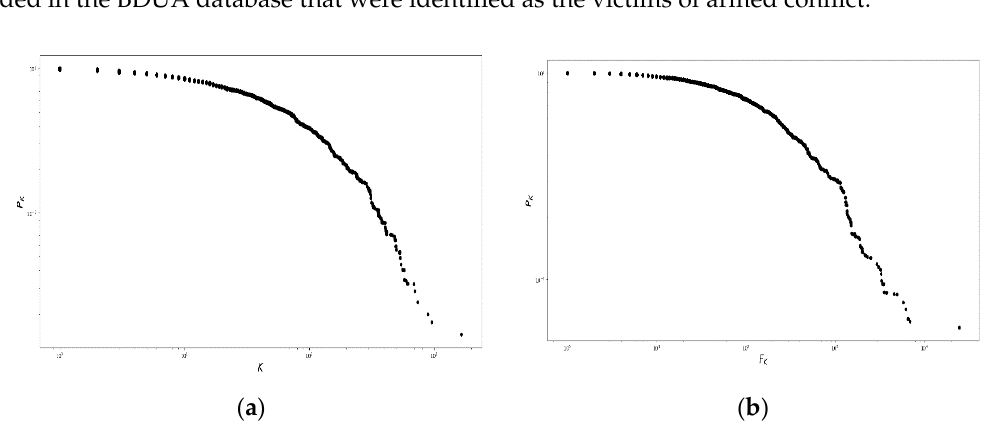
Figure 6. Nodal degree and nodal strength for the victims of the armed conflict in Colombia, resident in the Risaralda province. Complementary cumulative distribution functions of ( a ) the nodal degree K , and ( b ) the nodal strength 𝐹 𝐾 for the Morbidity Network of Diagnoses for the victims of the armed conflict in Colombia, residing in the Risaralda province , from 2011 to 2016. Source: authors’ own calculations.